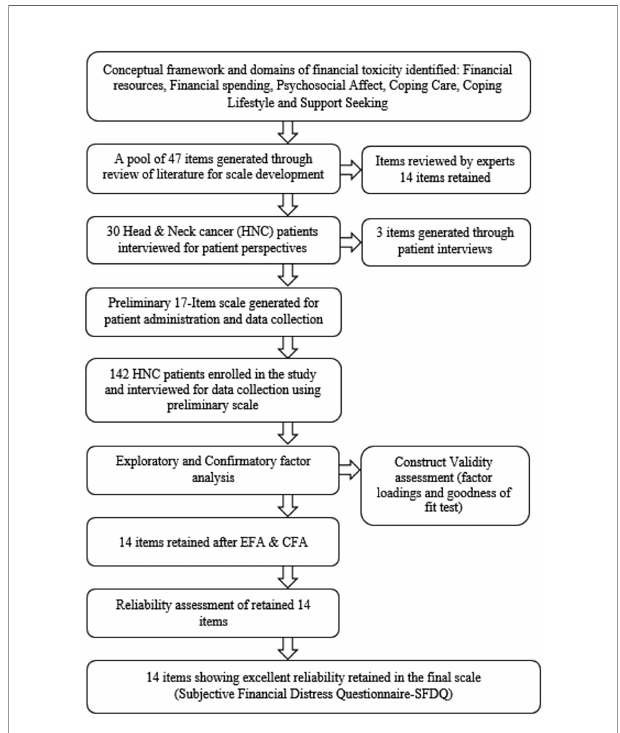
FIGURE 1 | Flowchart of the scale development